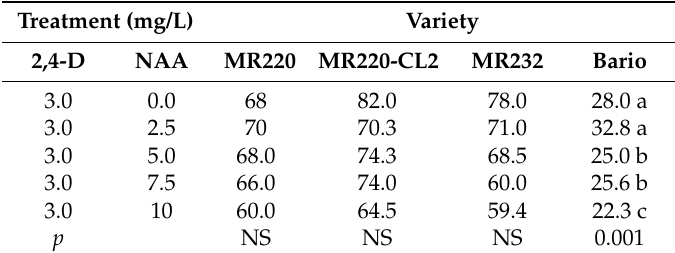
p NS NS NS 0.001 Mean values ( n = 3) marked with the same letters do not differ significantly ( p ≤ 0.05) in Tukey’s test. NS indicates as non-significant.